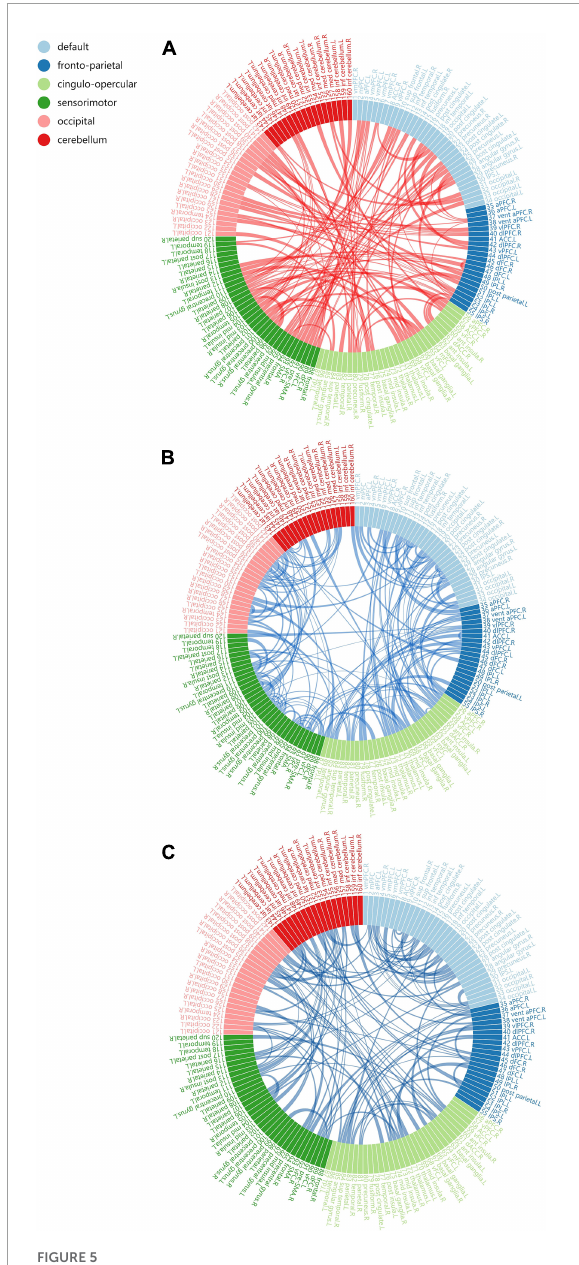
FIGURE5 Compared with Control Group ( p < 0.05, corrected). The neural circuits with altered functional connectivity strength in B Group (A,B) and A Group (C) . Edge colors represent increased (red) and decreased (blue) functional conneetivity strength in the volunteers. Edge sizes represent the level of significance (for more information about the functional connectivity changes, please refer to Supplementary File 3